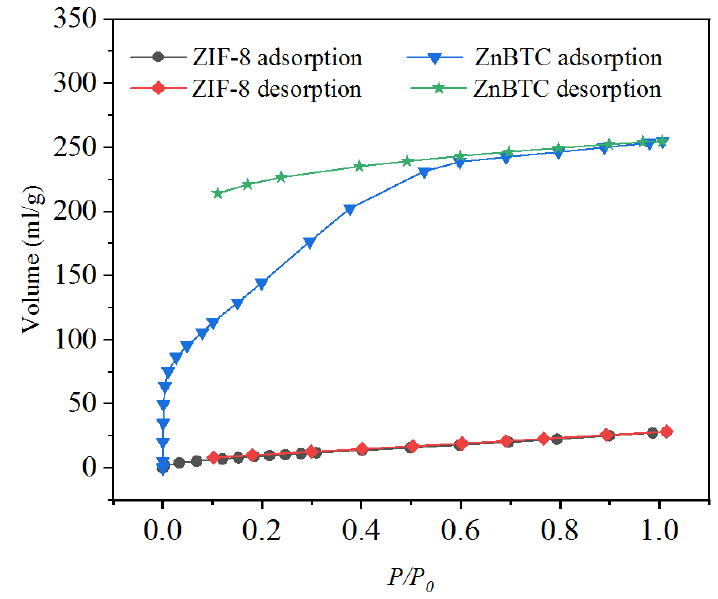
Figure 4. NH 3 adsorption and desorption curves obtained for ZnBTC and ZIF-8.